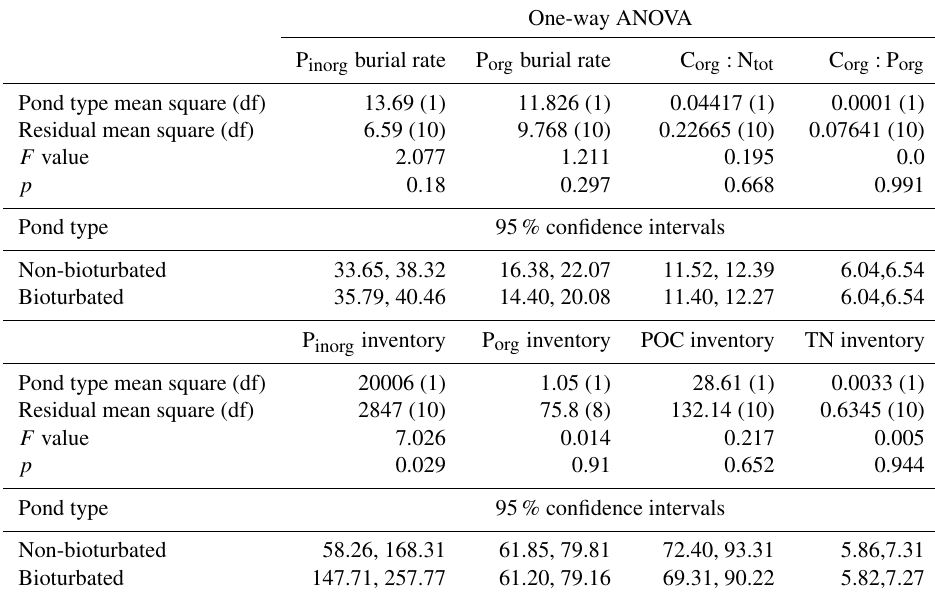
Table A4. Results from one-way ANOVA analysis and calculated 95% confidence intervals. Residuals were tested for normality and hetero- geneity; all passed these assumptions except C : P, which was log-transformed. df: degrees of freedom.